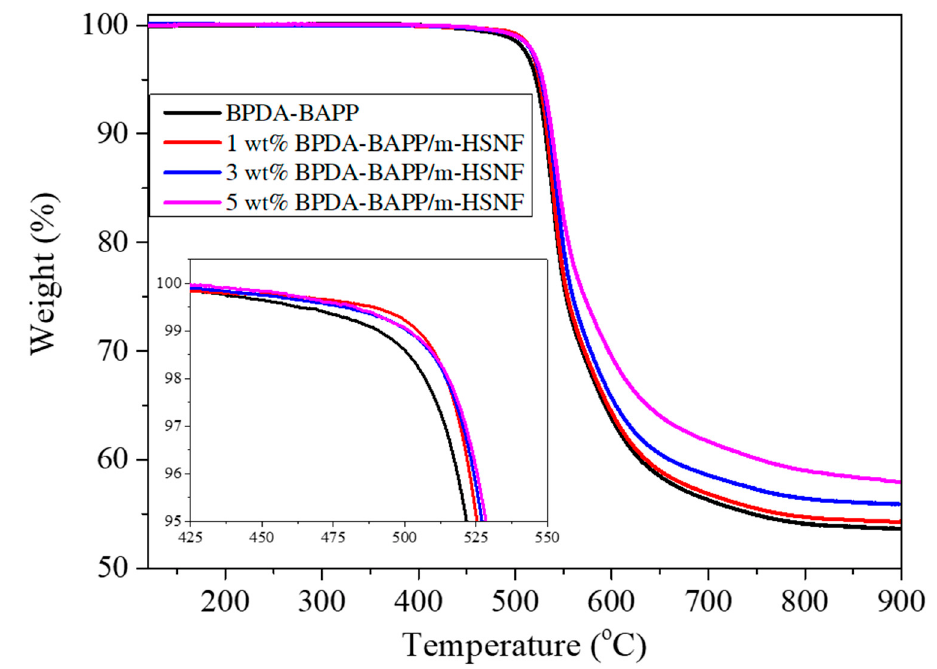
Figure 3. TGA and the temperature of 5 wt% weight loss (insert) curves of BPDA-BAPP/m-HSNF nanocomposites. Table 2. Thermal and mechanical properties of polyimide/m-HSNF composites.